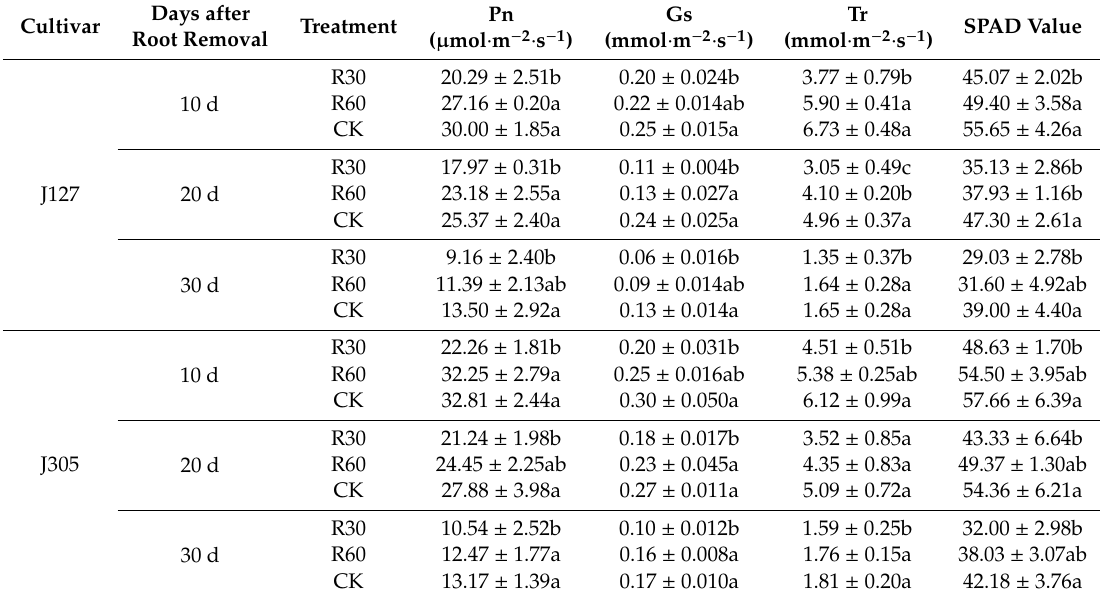
Table 1. E ff ects of root removal in di ff erent soil depths on photosynthetic parameters and SPAD values. Days Cultivar